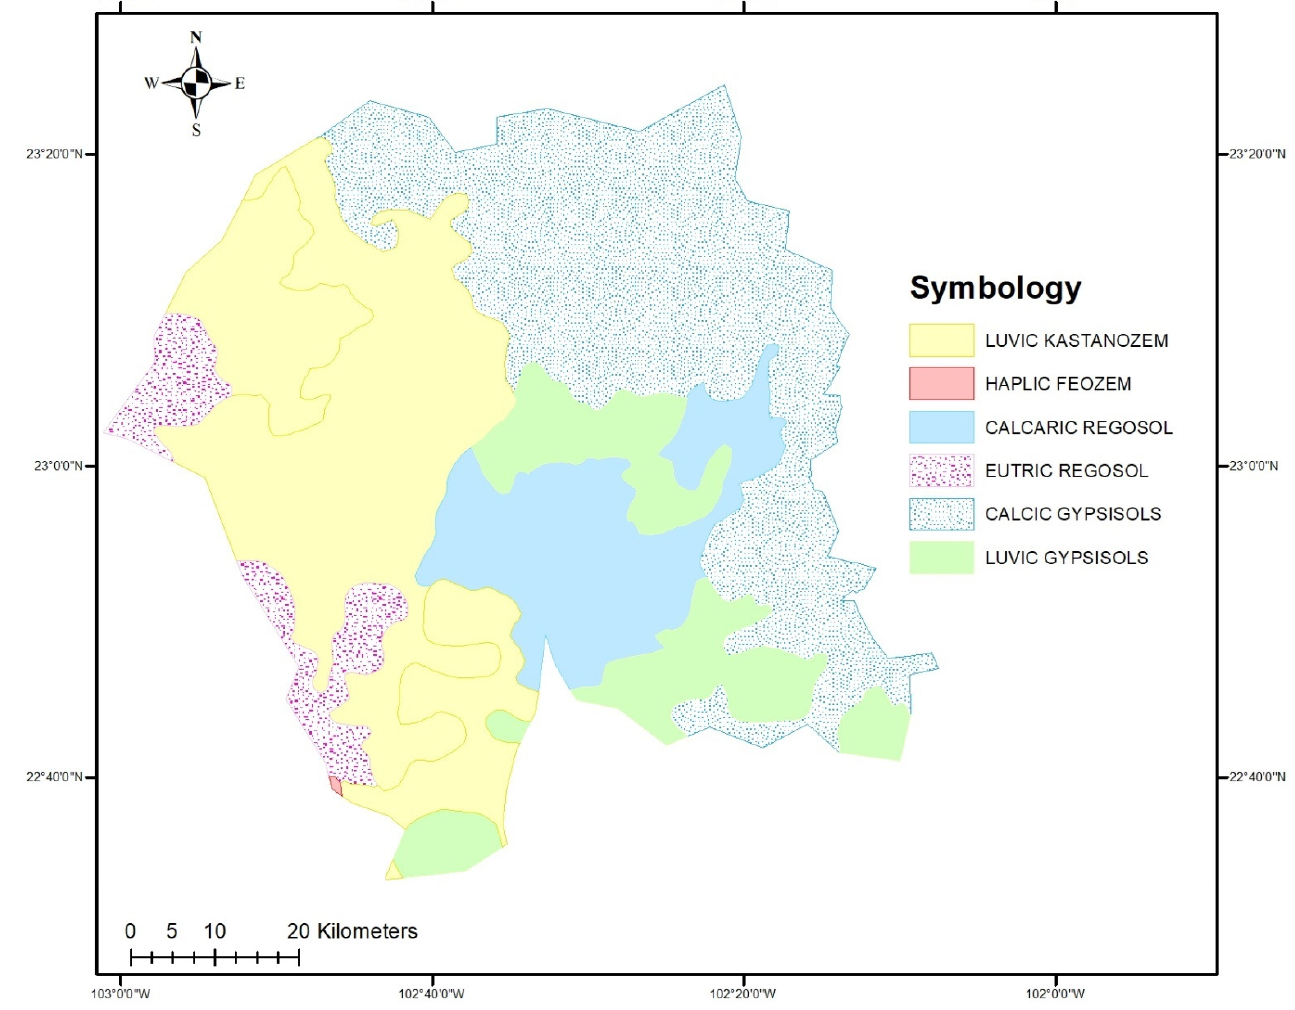
Figure 2. Edaphology of the study area.